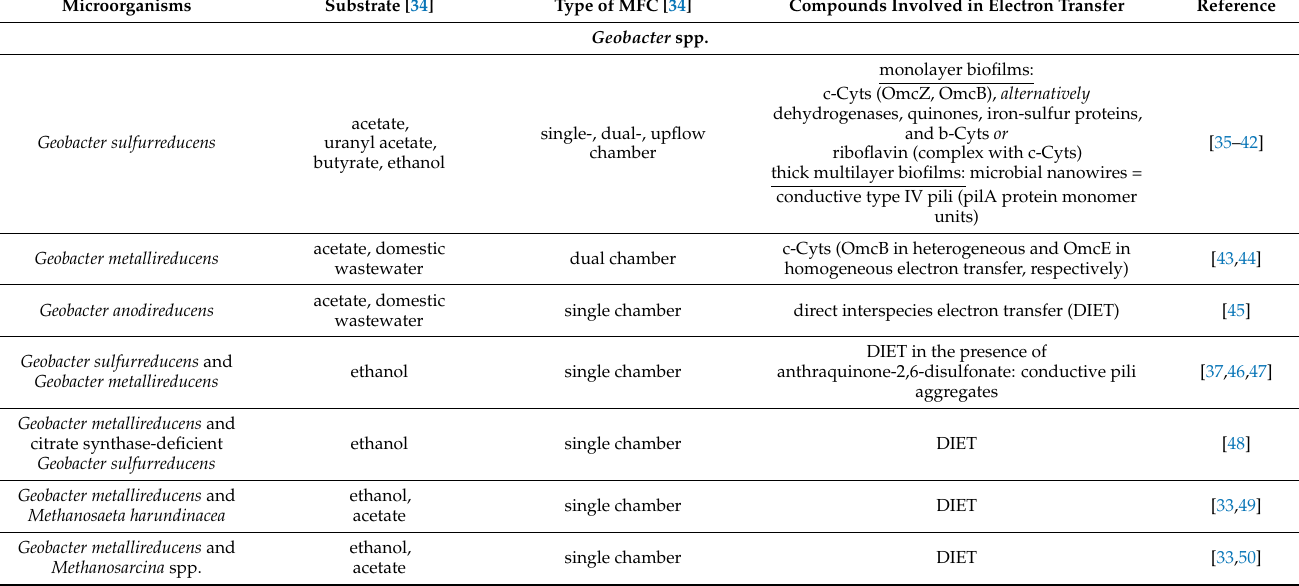
Table 1. Microorganisms used in microbial fuel cell (MFC) systems for their extracellular electron transport mechanisms.